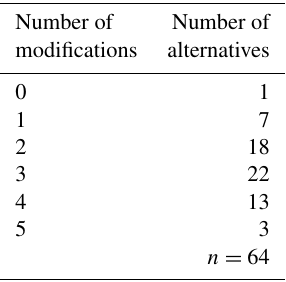
Table 3. Number of model structure alternatives containing a given number of snow routine